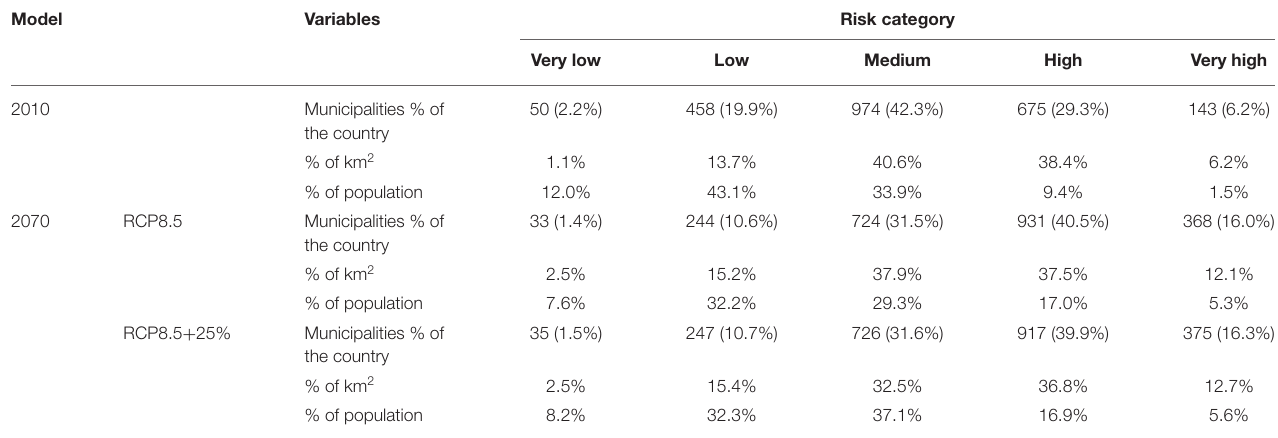
TABLE 4 | Risk categories of municipalities, based on historical data (2010), and the RCP8.5 and RCP8.5 + 25% scenarios.